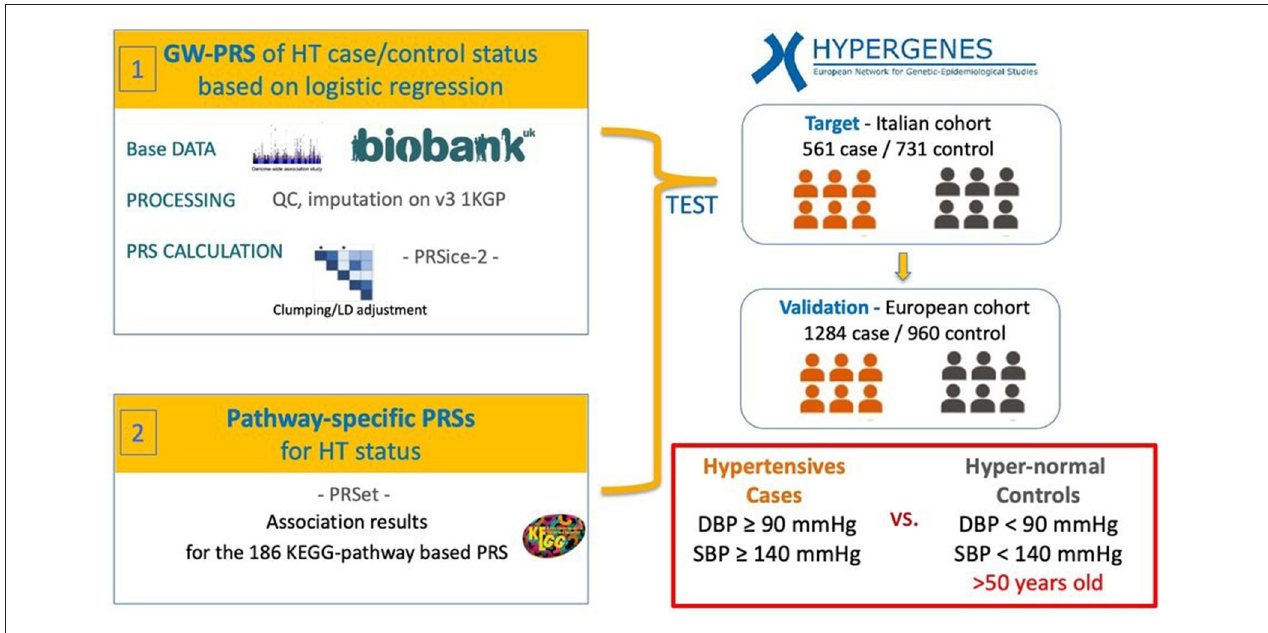
FIGURE 1 | Workflow of the analysis. Hypertension-PRS based on a reference hypertension-GWAS performed on the UK Biobank were calculated in the Italian hypertension (HT) case/control target cohort from the HYPERGENES dataset. The models were then validated in an independent European-wide HT case/control cohort within the HYPERGENES dataset. The analysis was performed both for genome-wide PRS and for pathway-specific PRS according to 186